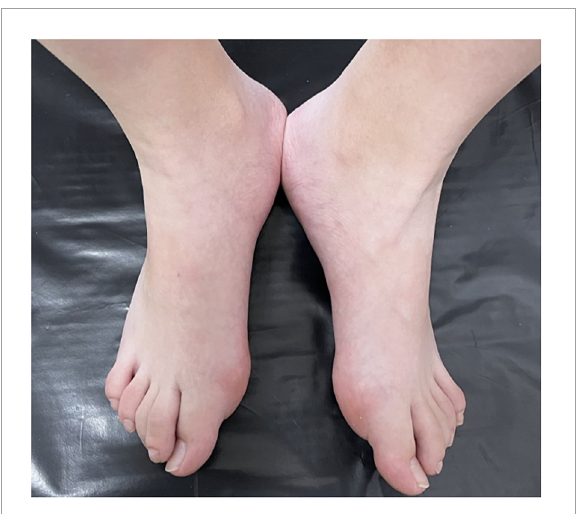
FIGURE2 Halluces were characterized by hallux valgus deformity with macrodactyly.